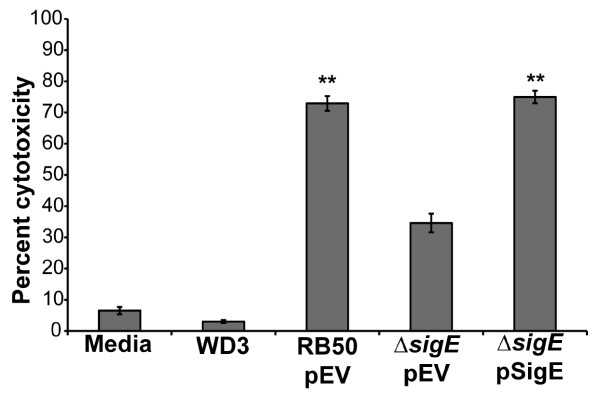
RB50ΔsigE is less cytotoxic to macrophages than RB50. RAW 264.7 cells were incubated at an MOI of 10 with medium containing RB50 pEV, RB50ΔsigE pEV, RB50ΔsigE pSigE, TTSS-deficient RB50 strain WD3, or medium alone for 4 hours in the presence of 1 mM IPTG to induce expression of sigE from the pLac promoter of pSigE. The average percent cytotoxicity of four wells in four separate experiments as measured by (LDH release from a well/LDH release from the positive control well) x100 ± SE is shown. The differences in percent cytotoxicity between RB50ΔsigE pEV and either RB50 pEV or RB50ΔsigE pSigE are statistically significant (** indicates P value < 0.01), while the cytotoxicities of RB50 pEV and RB50ΔsigE pSigE are not significantly different.